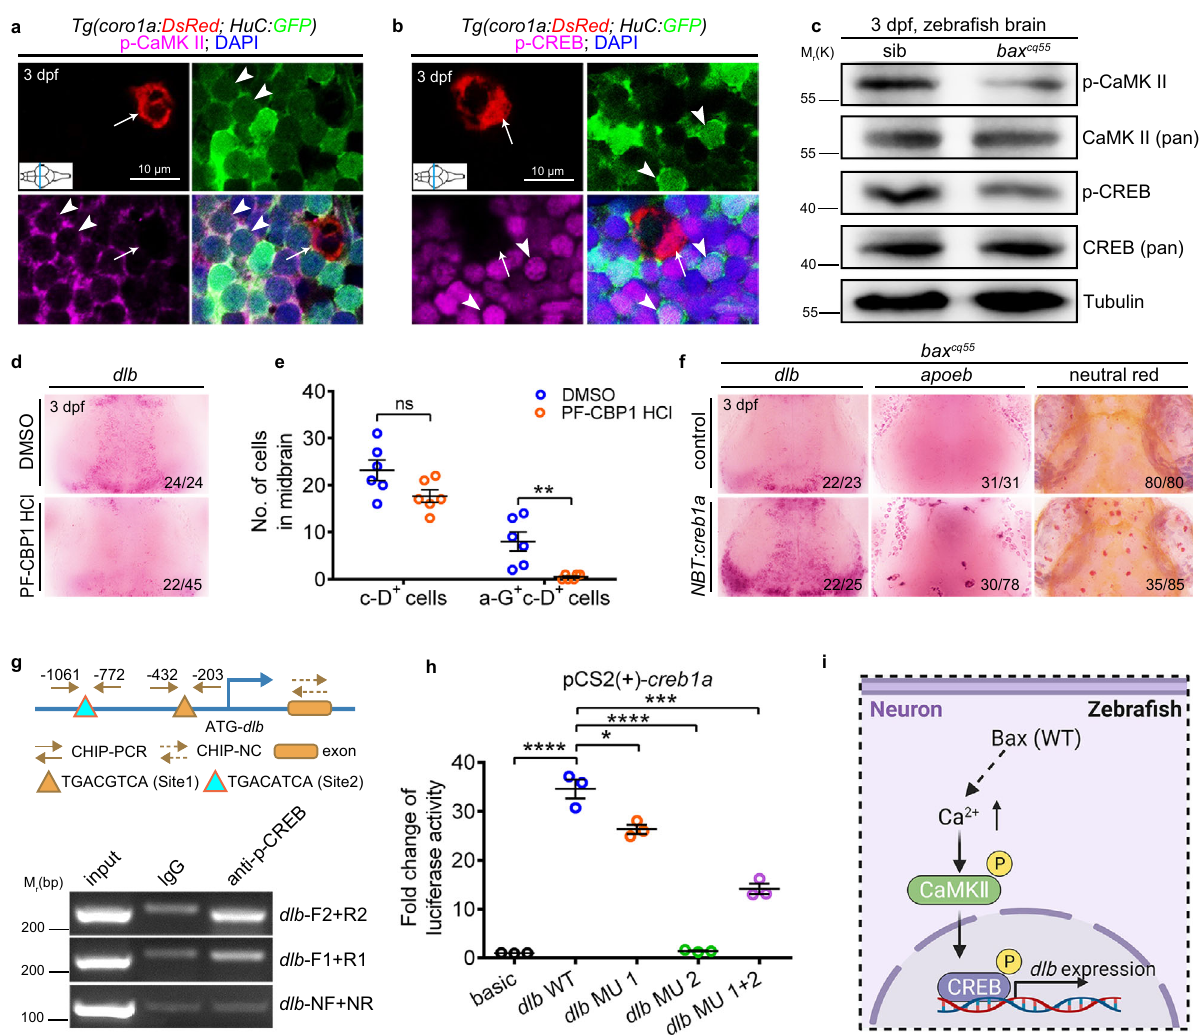
Fig. 6 | The CaMKII-CREB pathway regulates dlb expression and microglial maturation. a Immuno fl uorescence of p-CaMKII (magenta), H-G (green) and c-D (red)inthetransversesectionsof3dpfWTmidbrain.p-CaMKIIco-stainedwithGFP + (white arrowhead) but not DsRed + (white arrow) signals. b Immuno fl uorescence of p-CREB(magenta),H-G(green)and c-D (red)inthetransversesectionsof 3dpf WT midbrain. p-CREB merged with GFP + (white arrowhead) but not DsRed + (white arrow)signals. c WBofp-CaMKII,CaMKII(pan),p-CREB,CREB(pan),andTubulinin the brain cells from 3 dpf siblings and bax cq55 mutants. The experiments were repeated three times and the results weresimilar. d WISHof dlb in 3 dpf midbrains after treated with DMSO or PF-CBP1 HCl. e The number of c-D + and a-G + c-D + signals in 3 dpf midbrains after DMSO and PF-CBP1 HCl treatment. Each dot denotes one fi sh ( n =6 in each group). f Representative images of dlb and apoeb WISH, and NR staining in the bax cq55 midbrains after supplying NBT:creb1a . g Top panel: the